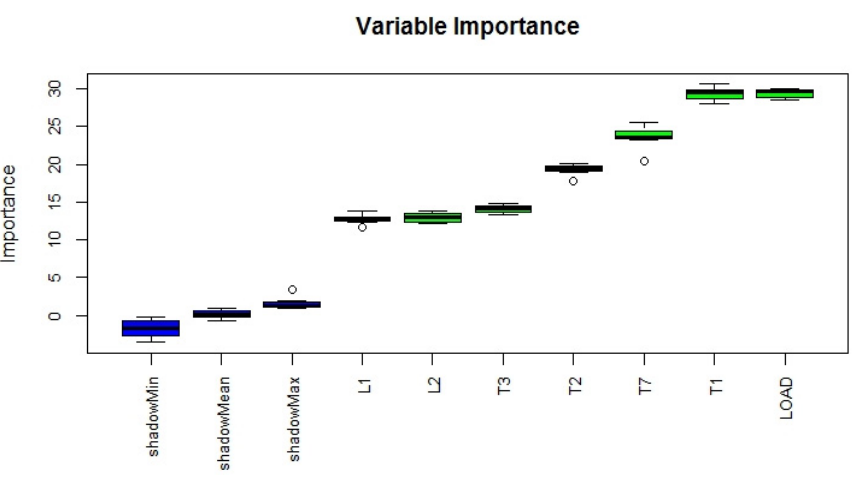
Figure 15. Boruta analysis for electricity price at 22:00.